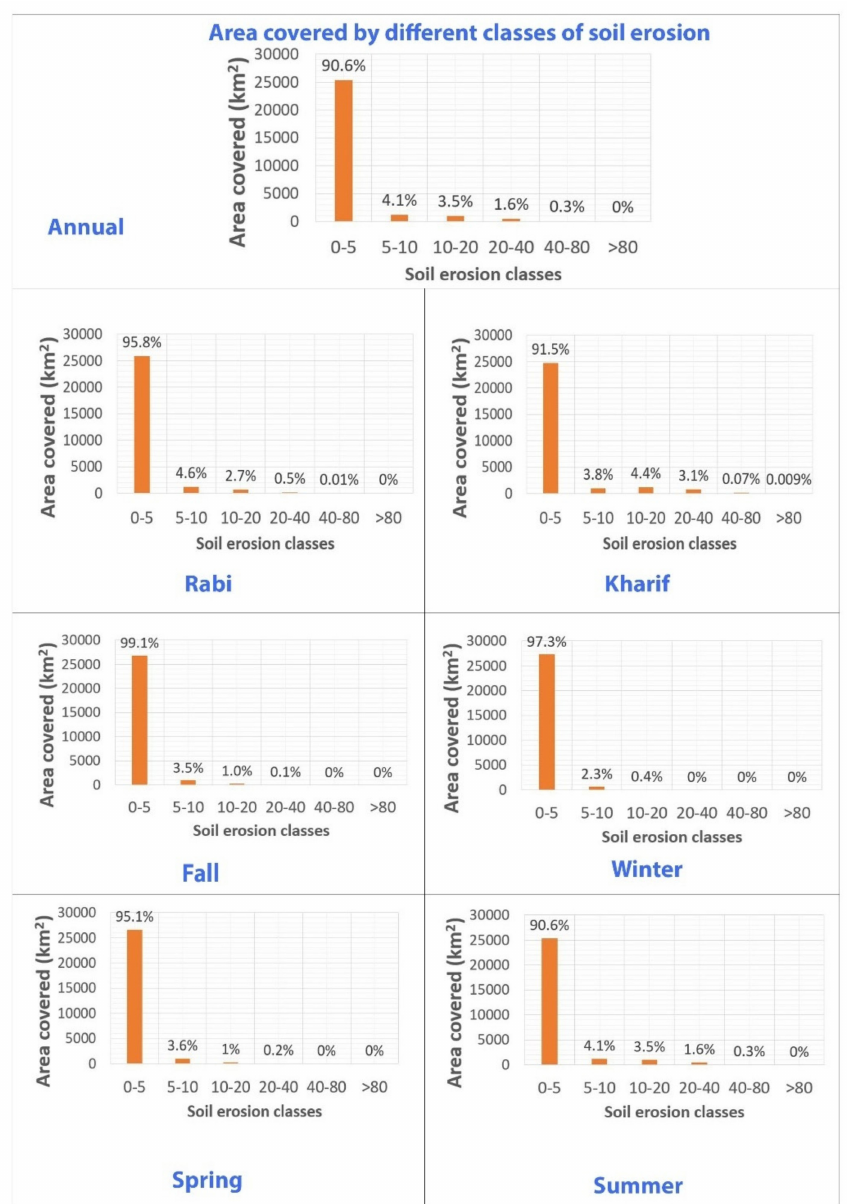
Figure 8. Catchment area percentage under different soil erosion classes based on PSE